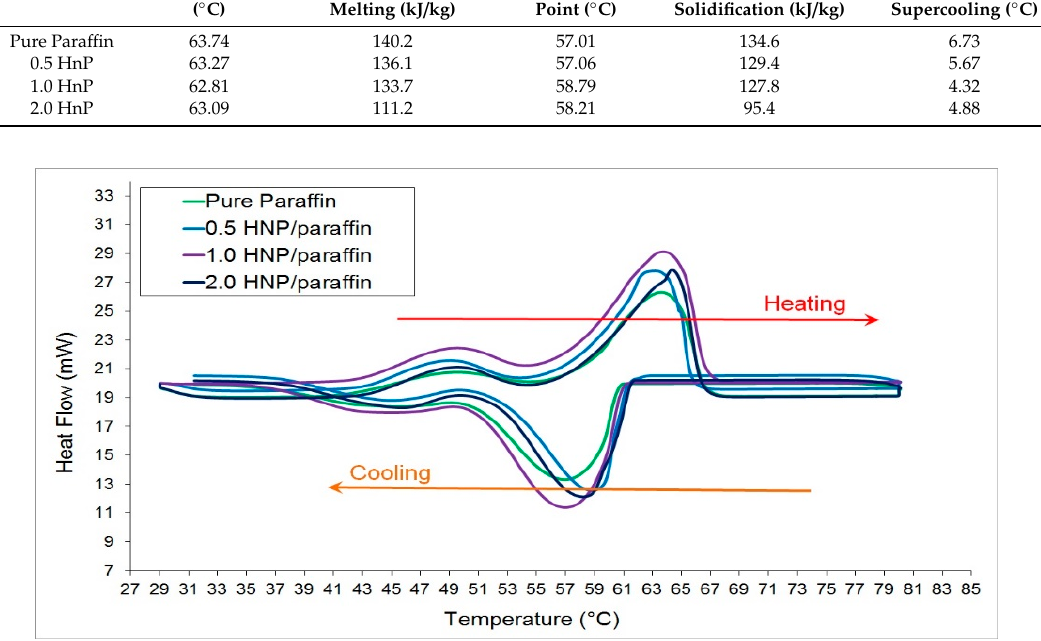
Figure 5. DSC results of the hybrid-nano/paraffin samples. Table 3. Thermal properties of hybrid-nano/paraffin samples assessed with DSC.